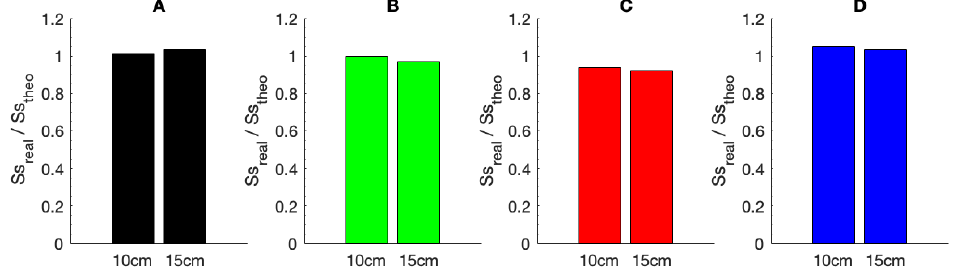
Figure 16. Ratio of realised ( S s T p = 1.81 s, Hs = 10 cm, and 15 cm sea-states for facilities ( A – D